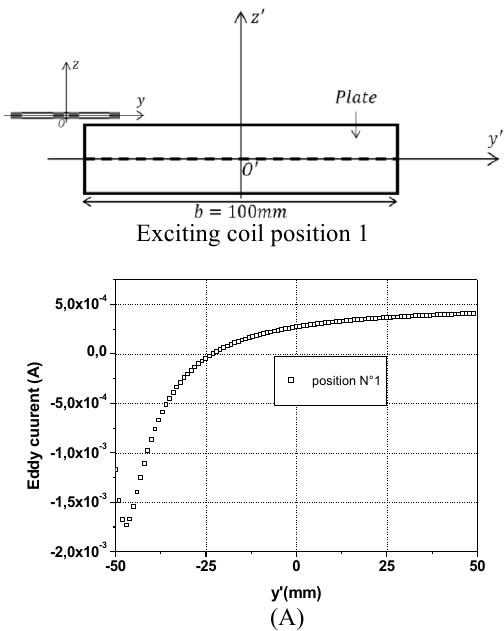
Figure 6 (A): Induced currents corresponding to the case of